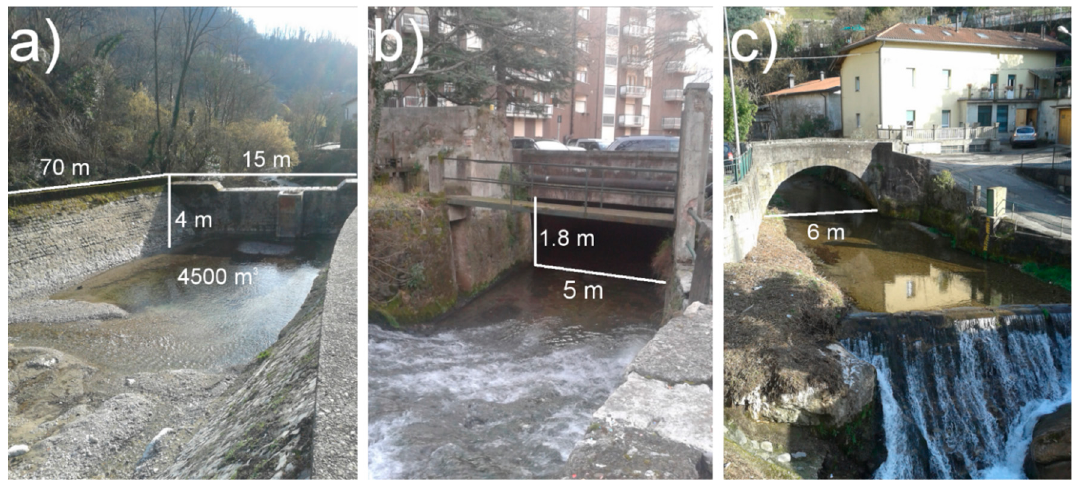
Figure 3. Key spots in the Caldone River: ( a ) Sedimentation pond in reach 6; ( b ) culvert entrance in reach 11; ( c ) level gauge in reach 7, notice the check dam used as hydraulic model constrain.